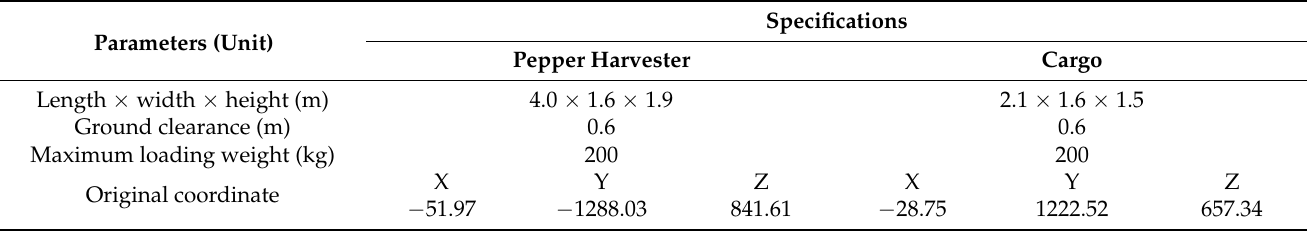
Table 1. Specifications of the vehicles.